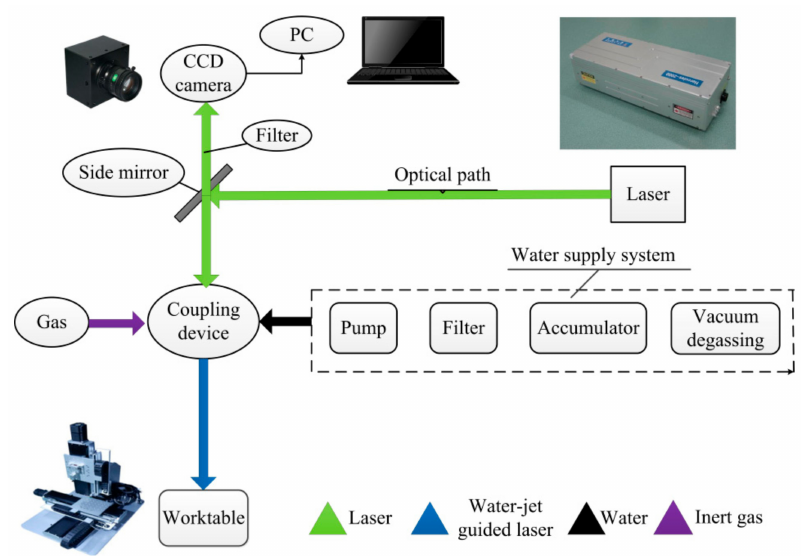
Figure 1. The schematic diagram of water jet-guide laser machining experimental platform.